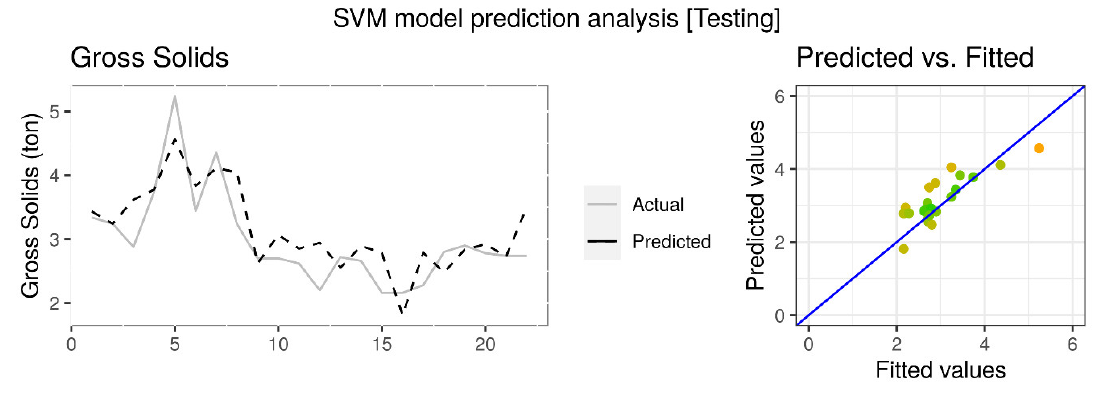
Figure 7. Analysis of results in the testing phase.